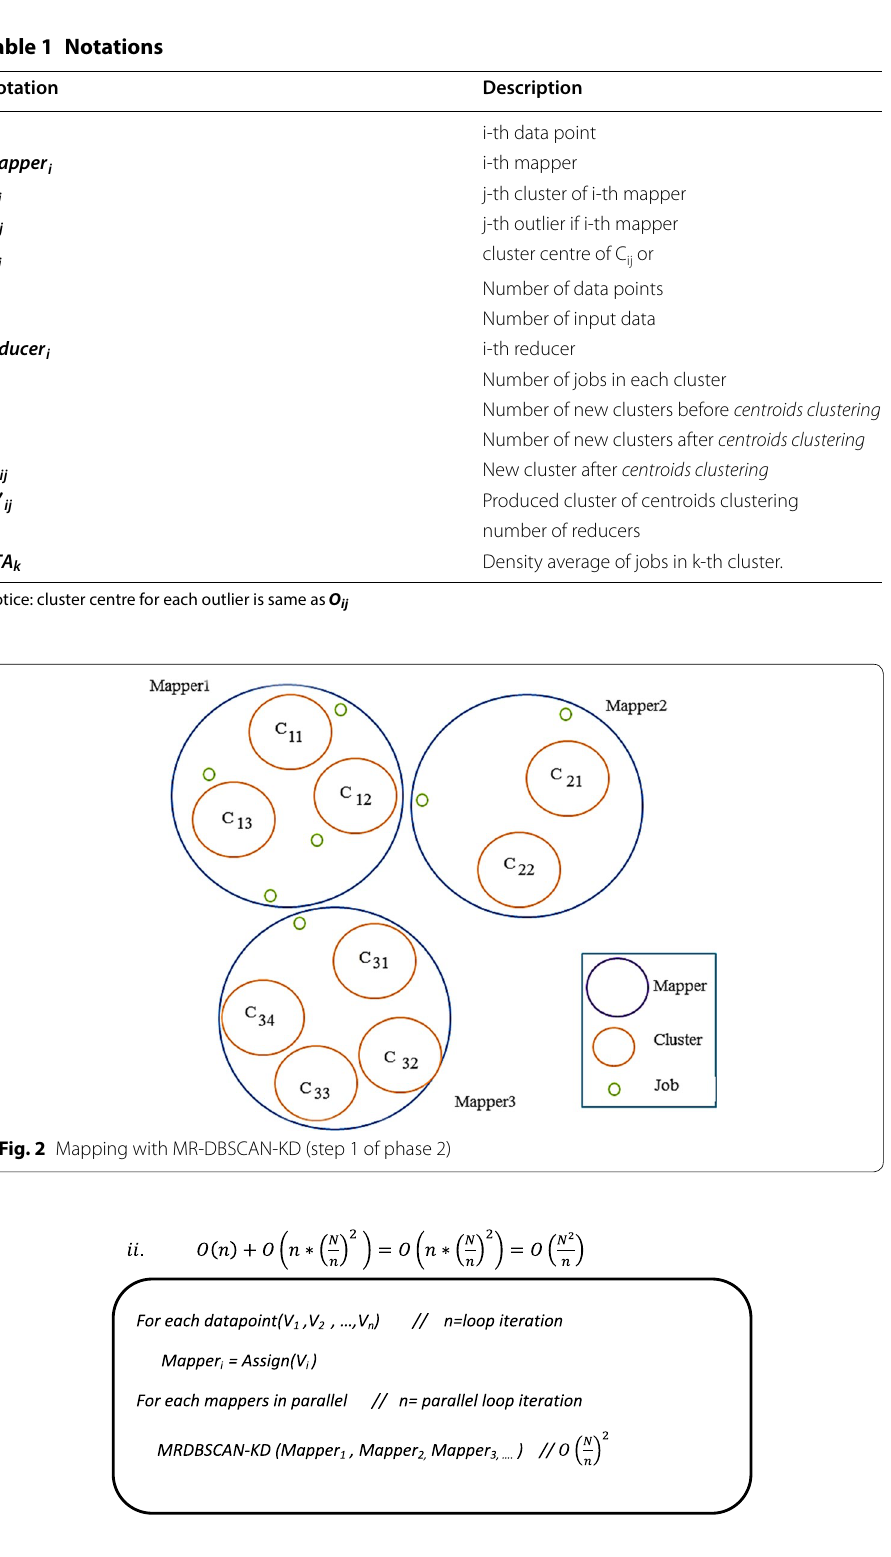
Algorithm 2. Assigning data points to mappers.